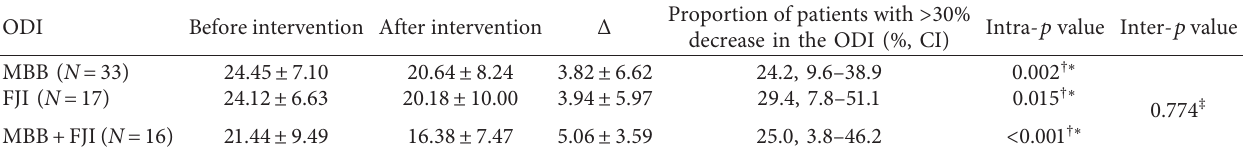
Table 3: Pre- and postintervention changes in the ODI in the three groups. Proportion of patients with > ODI Before intervention After intervention Δ